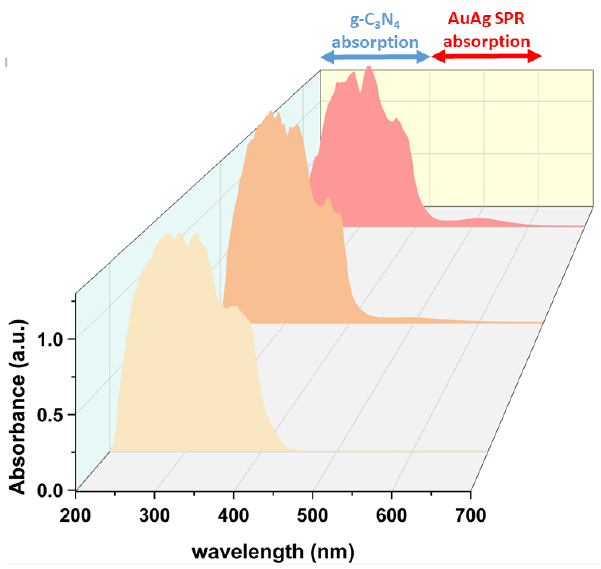
Figure 6. Solid UV-vis spectra for pristine g-C 3 N 4 1 (beige) and AuAg-g-C 3 N 4 nanohybrids 2 (orange) and 3 (red).